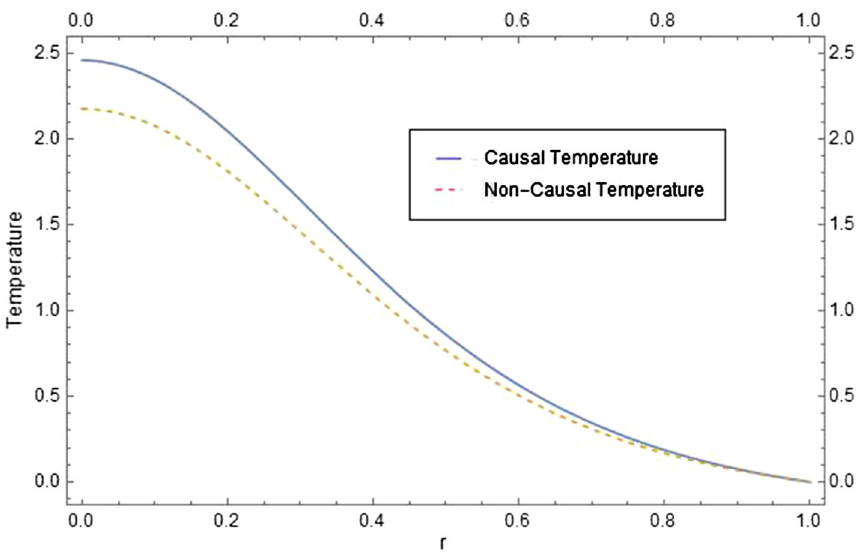
Fig. 5 Plot of the causal and noncausal temperature T of the star with respect to r for σ =